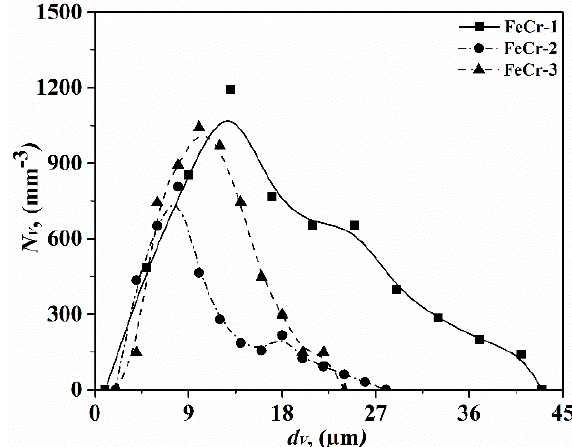
Figure 6. Particle size distributions of type A inclusions in three different FeCr alloys.